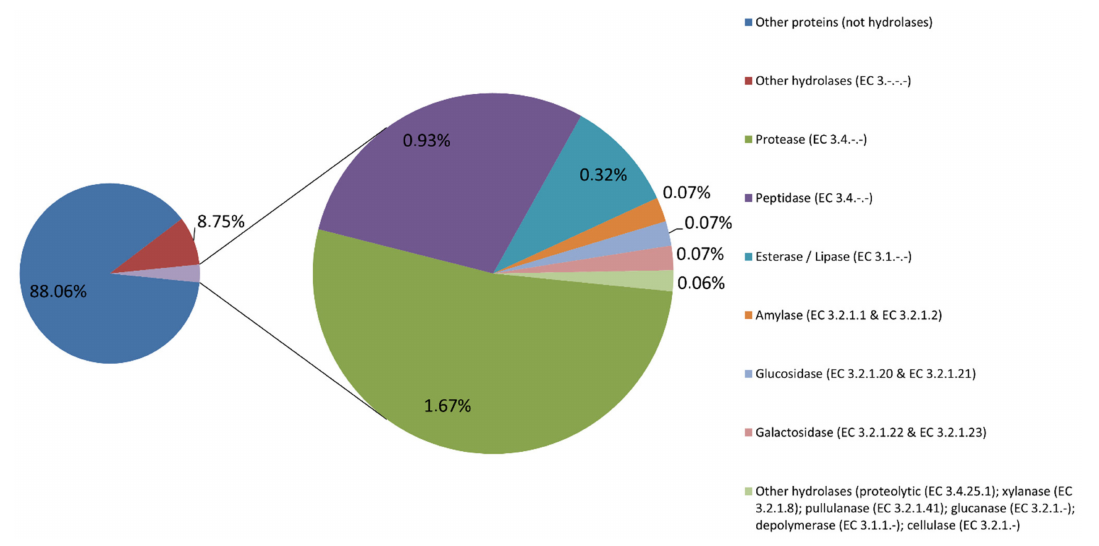
Figure 1. Relative abundances of hydrolases from the metagenomic sample obtained in Muiño da Veiga. Abundance was measured as the number of counts obtained by the DIAMOND aligner using a SEED subsystems database clustered using an identity of 98% (in order to reduce the size of the original database). Out of 30,132,990 counts, 88.06% were assigned to a subsystem function different from hydrolases; 8.75% were found to be hydrolases with no direct biotechnological applications in industry. The remaining 3.19% were found to be hydrolases with possible interest in industrial pro- cesses: proteases, peptidases, esterases and lipases, amylases, glucosidases, galactosidases, proteolytic enzymes, xylanases, pullulanases, glucanases, depolymerases and cellulases. Relative abundances of each enzyme family are shown along with their EC number.